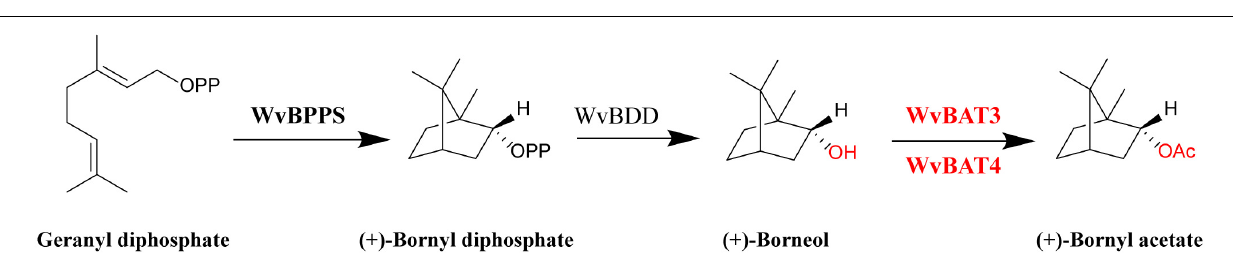
FIGURE 9 | Biosynthetic pathway of bornyl acetate (BA) in Wurfbainia villosa . BPPS: bornyl diphosphate synthase; BDD, bornyl diphosphate diphosphatase; BAT, bornyl acyltransferase. The WvBAT in red was identified to be the key enzyme involved in the synthesis of bornyl acetate (BA) in